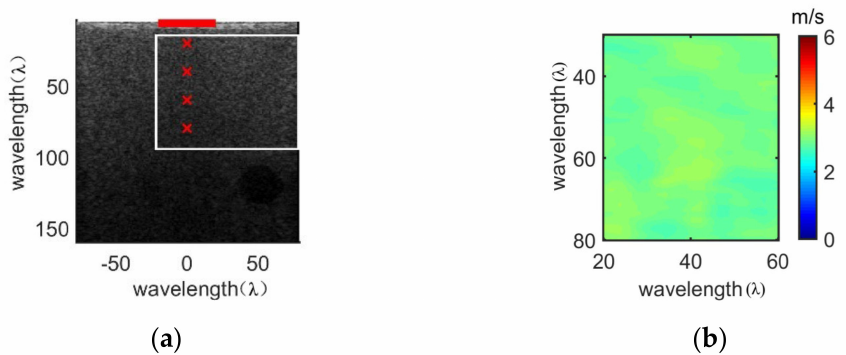
Figure 5. Velocity image reconstruction in the homogeneous region with the real-time curve tracing method. ( a ) The B-ultrasound image of region of interest. ( b ) The velocity